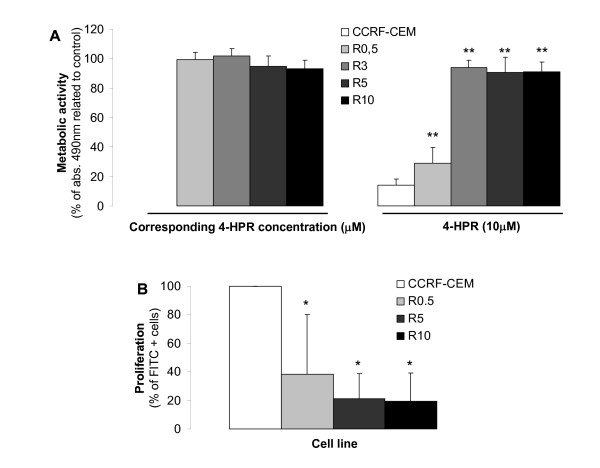
Acquired resistance upon long-term 4-HPR exposure. (A, left) R cell lines were continuously exposed to different 4-HPR concentrations (0.5, 3, 5, and 10 μM; cell lines named R0.5, R3, R5, and R10, respectively) and resistance verified by comparison to 48 h drug-withdrawn R cells. Data are the average ± SD of three independent experiments performed in quadruplicates, n = 12. (A, right) Parental CCRF-CEM cells and developed R cell lines were exposed to 10 μM 4-HPR and viability estimated after 48 h of drug exposure. (n = 12). **P < 0.01; ANOVA plus Tamhane post-hoc analysis. (B) Comparative cell proliferation was determined by BrdU labeling as specified in Materials and Methods. Data are average ± SD of four independent experiments. *P < 0.05; Kruskal Wallis and Mann-Whitney test for pair-wise comparison.